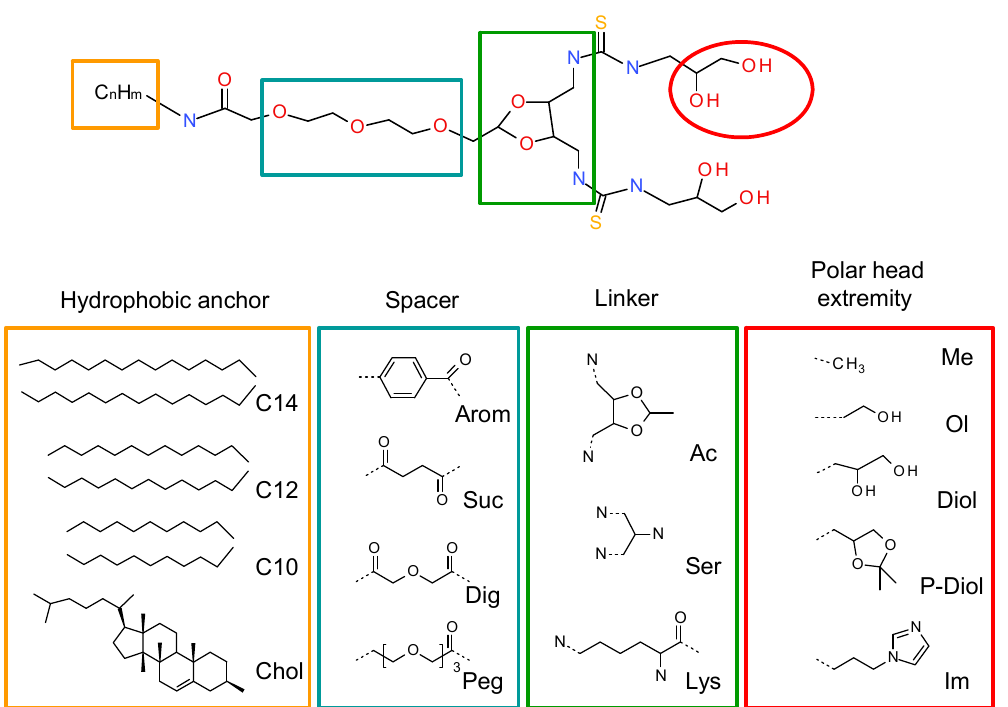
Figure 2. Screening of the different parts of the lipothiourea to optimise the amphiphilic balance as well as the transfection efficiency. The hydrophobic anchor was varied from aliphatic chains (C10, C12, C14) to a cholesterol residue. Aromatic, succinic, diglycolic and ethylene glycol spacers were tested. Acetal, serinol and lysine-based linker were compared. The extremity of the polar head was substituted either by a methyl, an alcohol, a protected or unprotected diol and an imidazole.